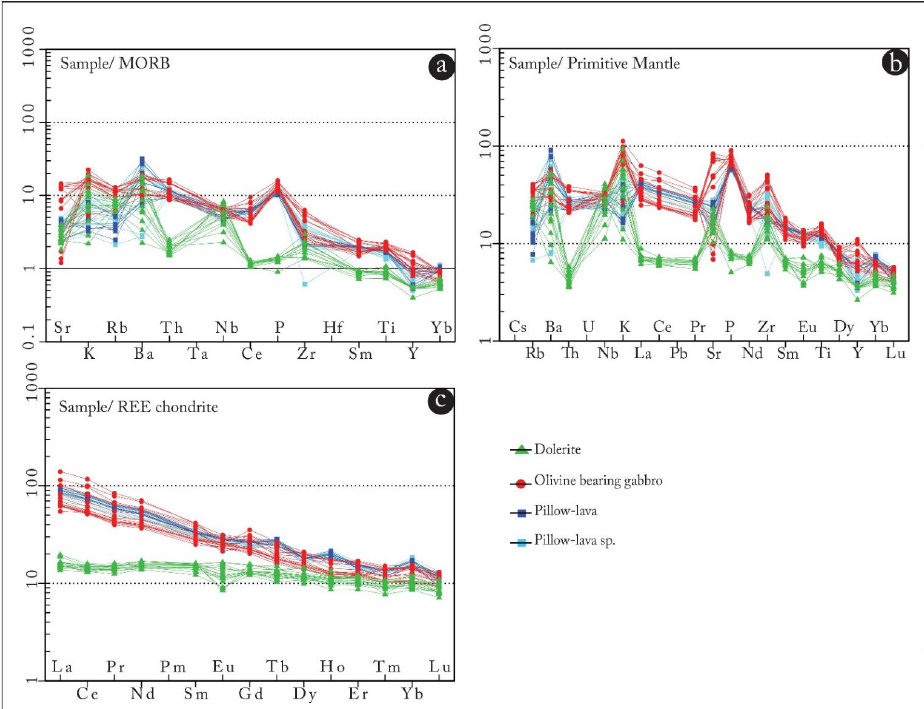
Figure 25. Multielement diagrams normalized to MORB [65] and ( a ) to primitive mantle [67] ( b ), spectra of rare earths normalized to chondrites [66] and ( c ) for magmatic rocks in the NNE